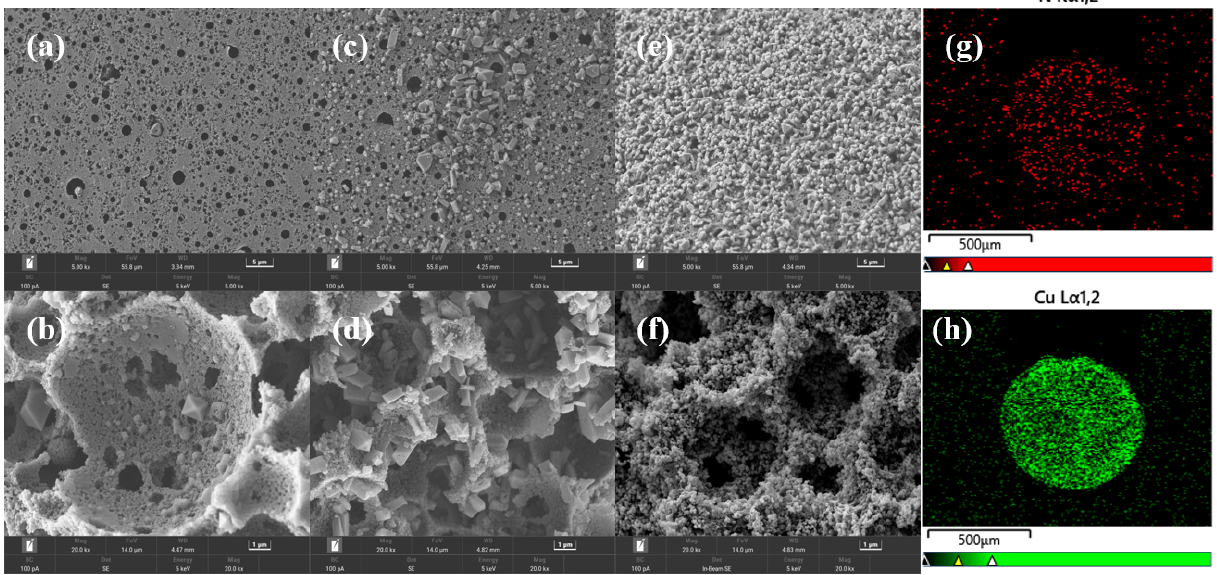
Figure 2 . The surface of the beads prepared by ( a ) the one-pot method; ( c ) the stepwise impregna-